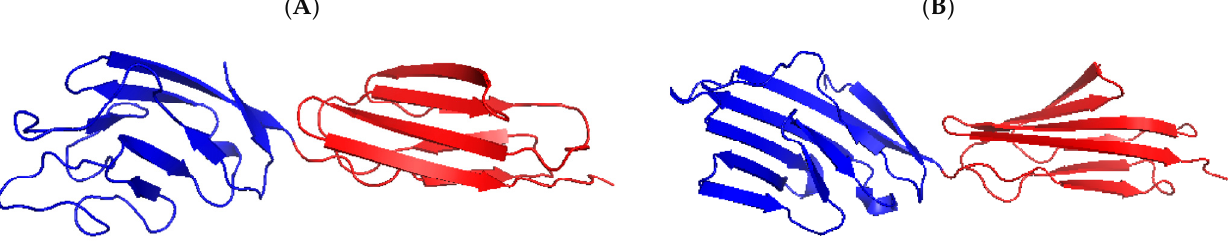
Figure 3. Predicted three-dimensional structure of the CD2v extracellular domain. ( A ) Homologous modeling analysis of the CD2v protein was performed using the software PyMOL 1.7 according to the structure of the human T cell adhesion molecule CD2 protein ( B ). The crystal structure of human T cell adhesion molecule CD2 protein (SMTL ID:1hnf.1). Immunoglobulin-like domains 1 and 2 were shown in blue and red, respectively.